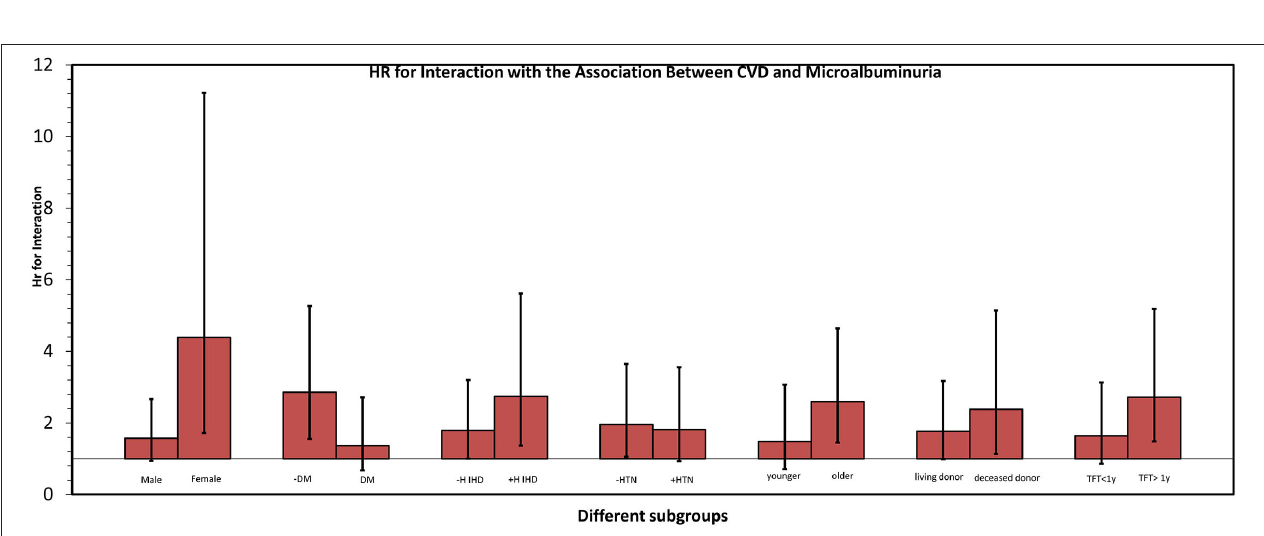
FIGURE 3 | Subgroup analysis of CVD risk according to presence of microalbuminuria. Each couple presents a certain subpopulation according to a certain risk factor. Each column illustrates the relation between Hazard Ratio (HR) (Y axis) and presence of a risk factor (X axis). Black line across each column represents Confidence Interval for HR. None of the interactions were significant with p = 0.078, p = 0.295, p = 0.376, p = 0.803, p = 0.451, p = 0.366, and 0.245 for interaction with gender, Diabetes Mellitus (DM), history of heart disease, hypertension, time from transplantation, living donor, respectively, and median age (56 years). DM, Diabetes Mellitus; TFT, time from transplantation, > / < 1 y, more or less than a year; H IHD, history of ischemic heart disease. Older/younger—above and below median age (56.6 years).